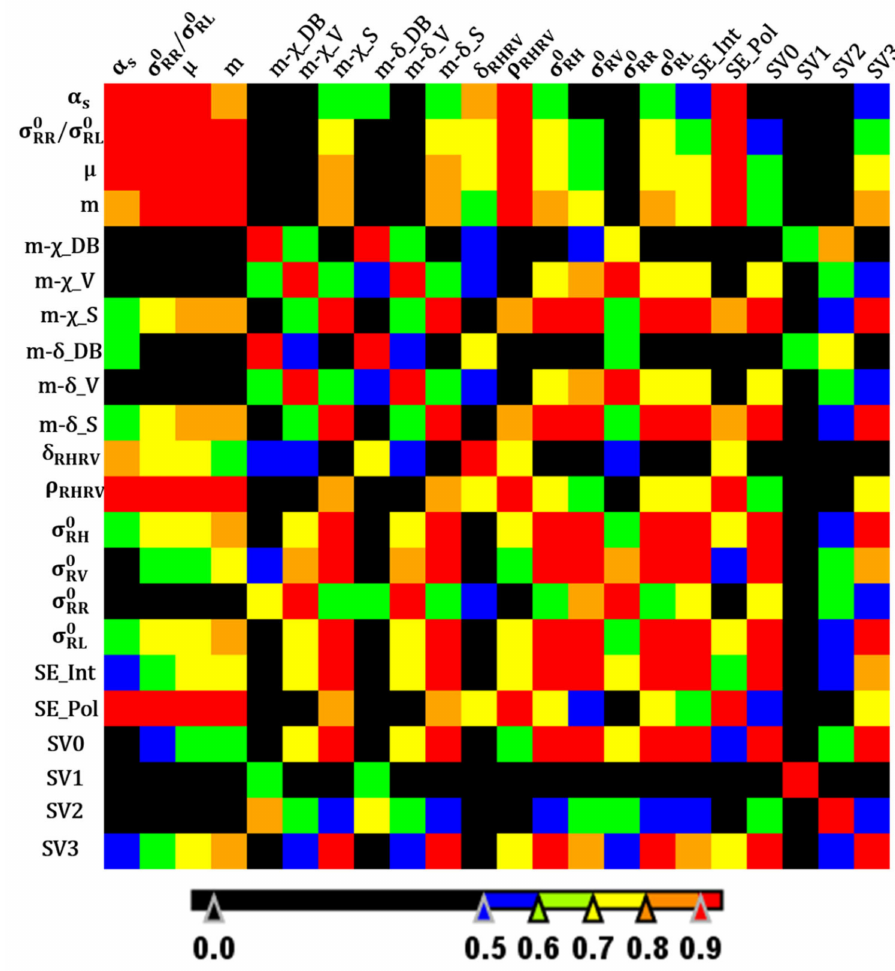
Figure 12. Absolute correlation between the CP